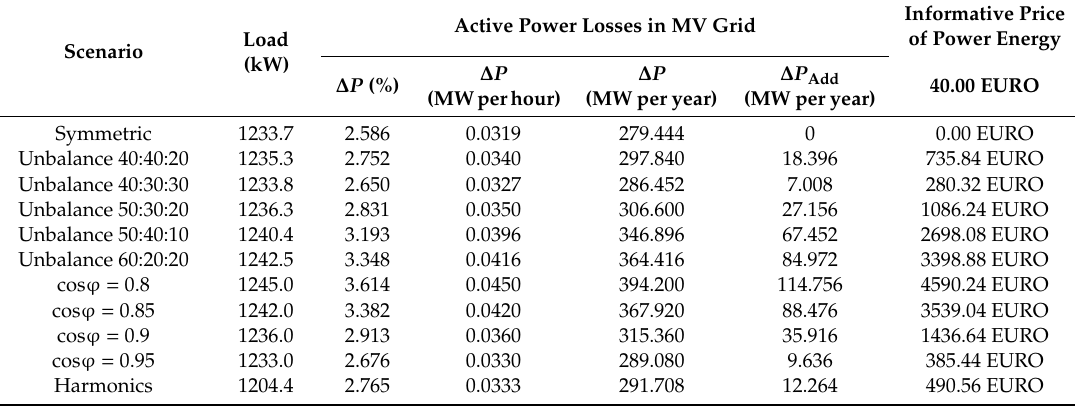
Table 5. Overview of active power losses and their impact on finance (ACSR 70 / 11, length of 20 km).